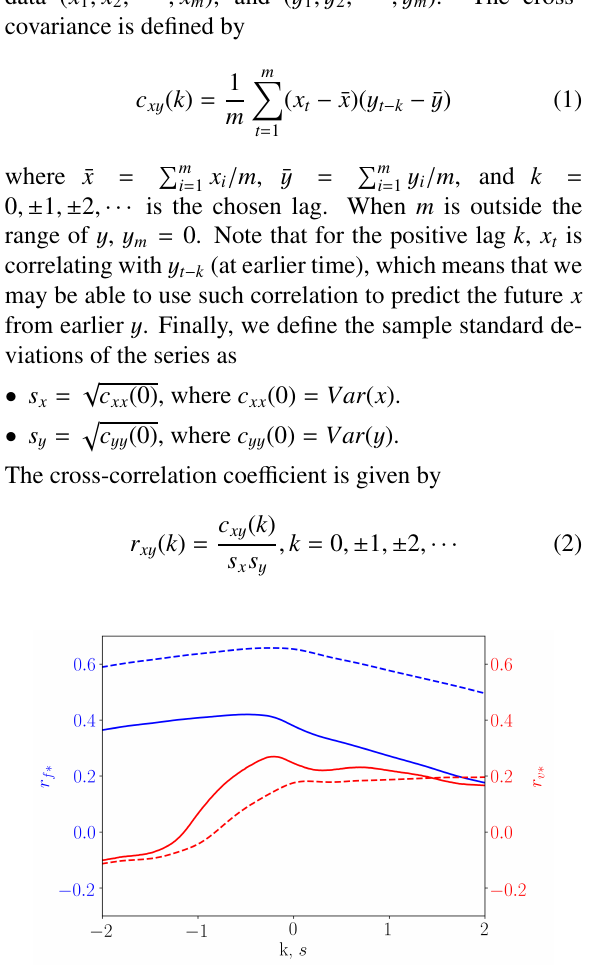
Figure 6: Cross correlation coe  cient as a function of lag k (in seconds). r f and r v for Exp. 1, where stands either ⇤ ⇤ ⇤ for W2 distance (solid line), or for TP (dashed